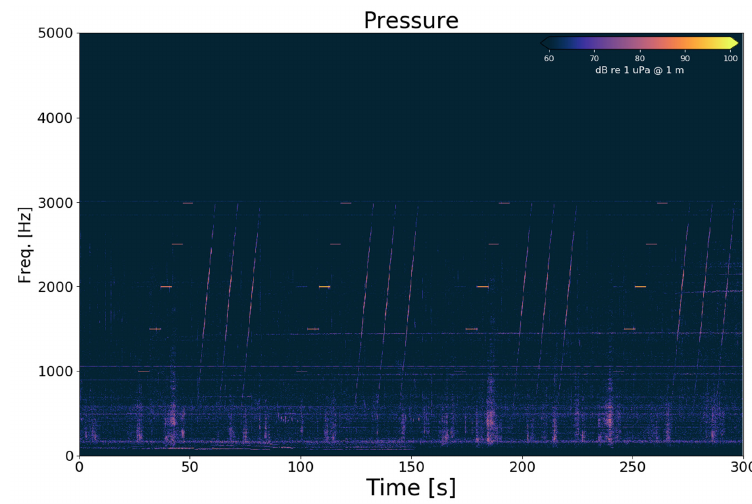
Figure 3. Pressure as measured on a single vector sensor in 26-m-deep water at the SB2 location, Sequim Bay, Washington, United States of America (USA).